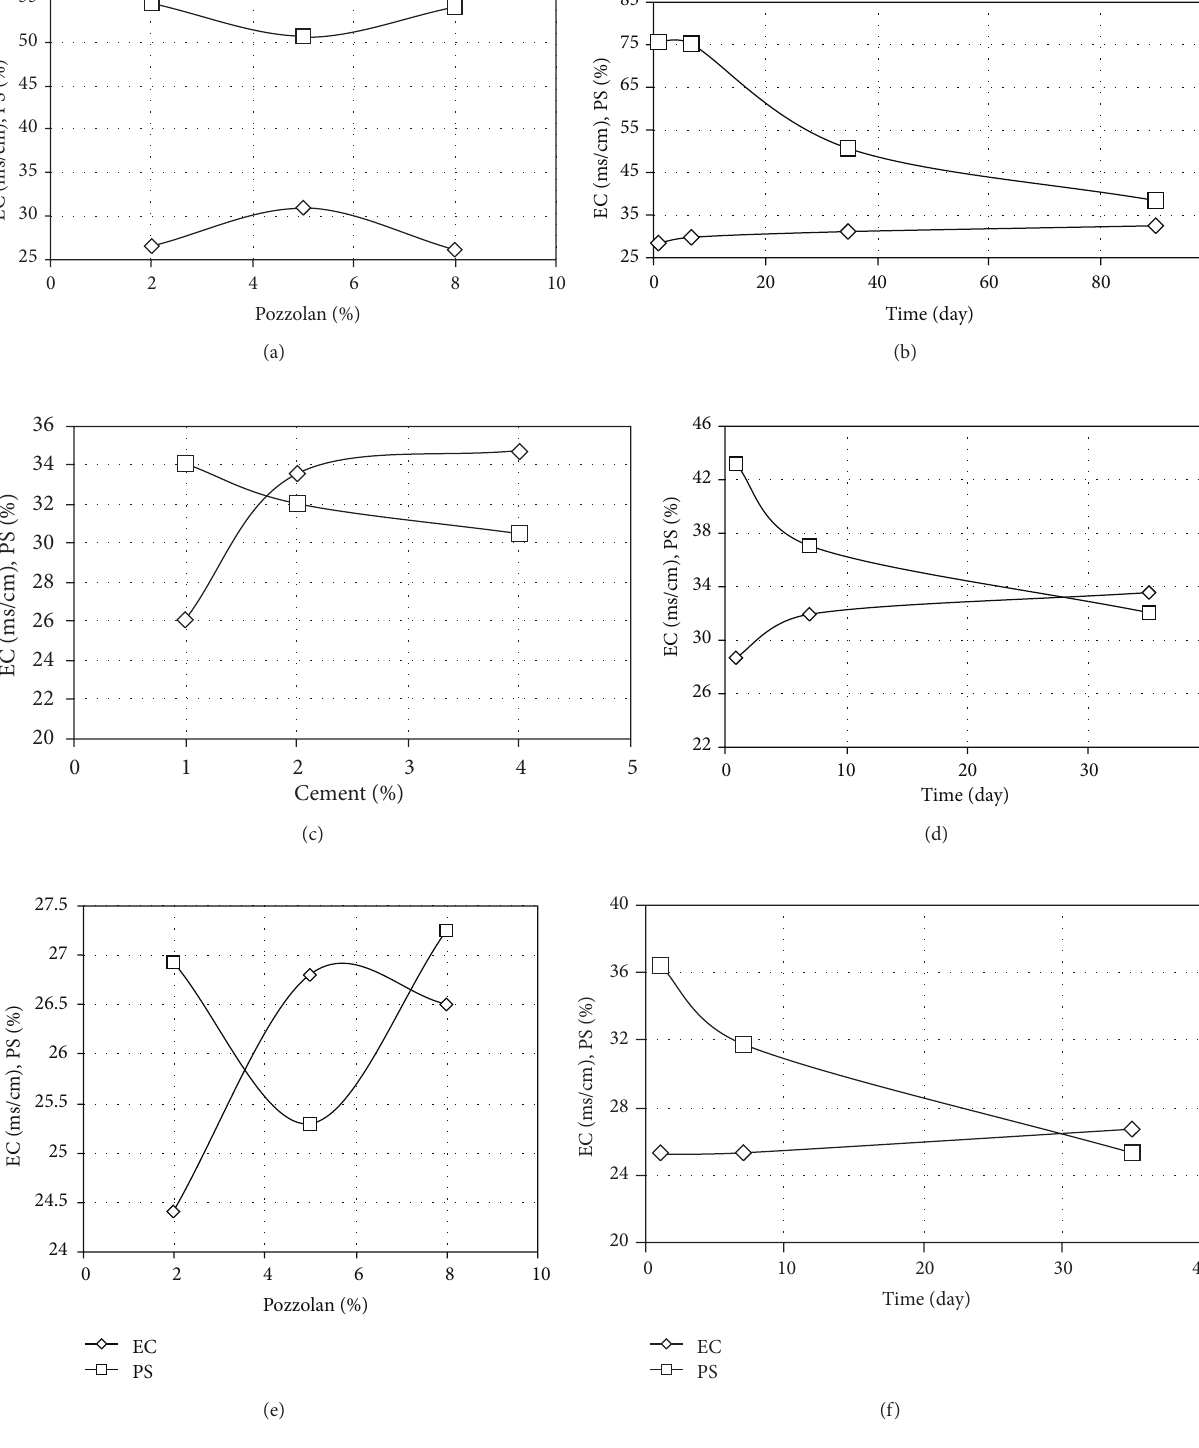
Figure 6: Electrical conductivity (EC) and percent sodium (PS) of samples treated: (a) with pozzolan and of 35 days curing time, (b) with 5% pozzolan and of various curing times, (c) with cement of 35 days curing time, (d) with 2% cement and of various curing times, (e) with 1.5% cement and various pozzolan percentages and of 35 days curing, and (f) with 1.5% cement and 5% pozzolan and of various curing